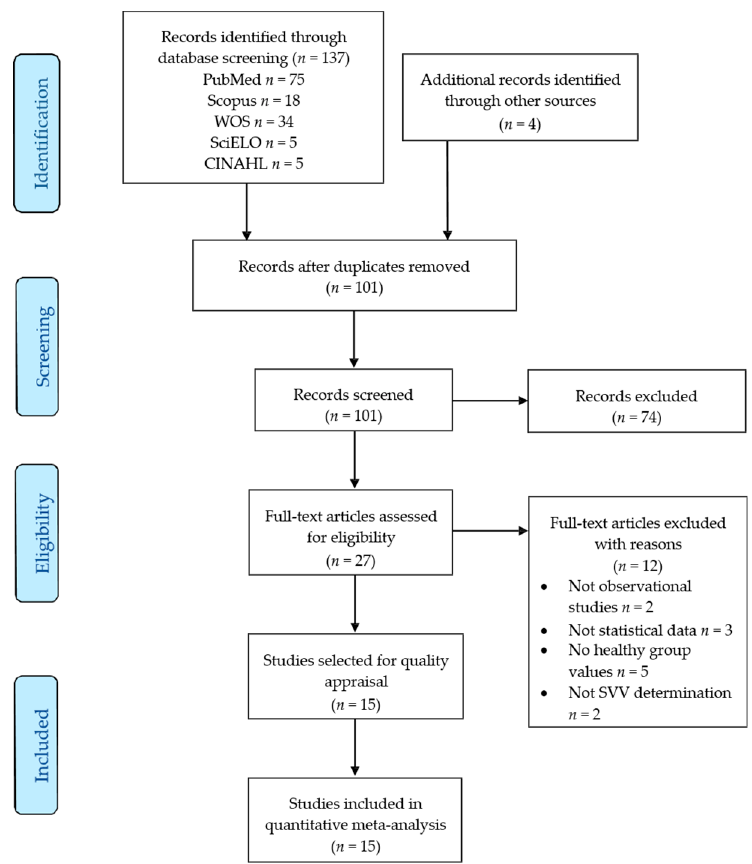
Figure 1. Preferred Reporting Items for Systematic Reviews and Meta-Analyses (PRISMA) flow chart.